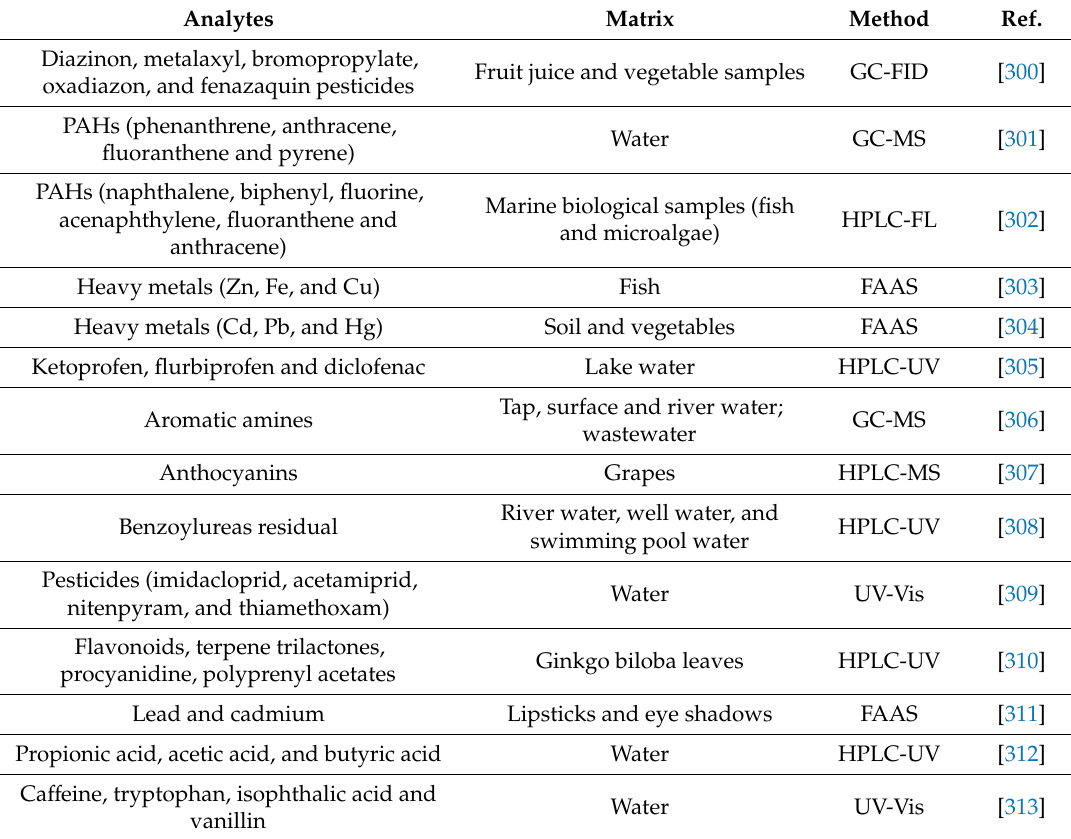
Table 4. Selected applications of deep eutectic solvents (DES) as green solvents in sample preparation. Analytes Matrix Method